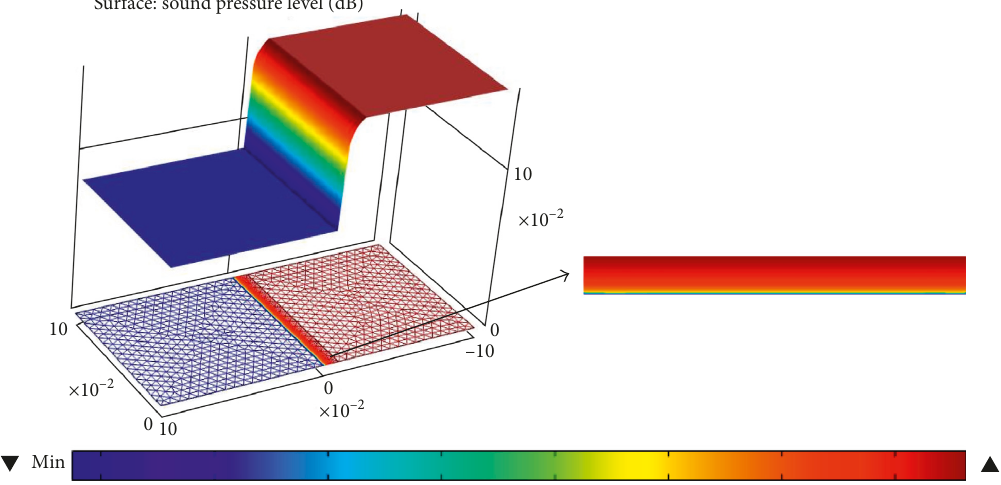
Figure 8: FEM model with the Thermo UM sample for investigating the minimum and maximum sample absorption.